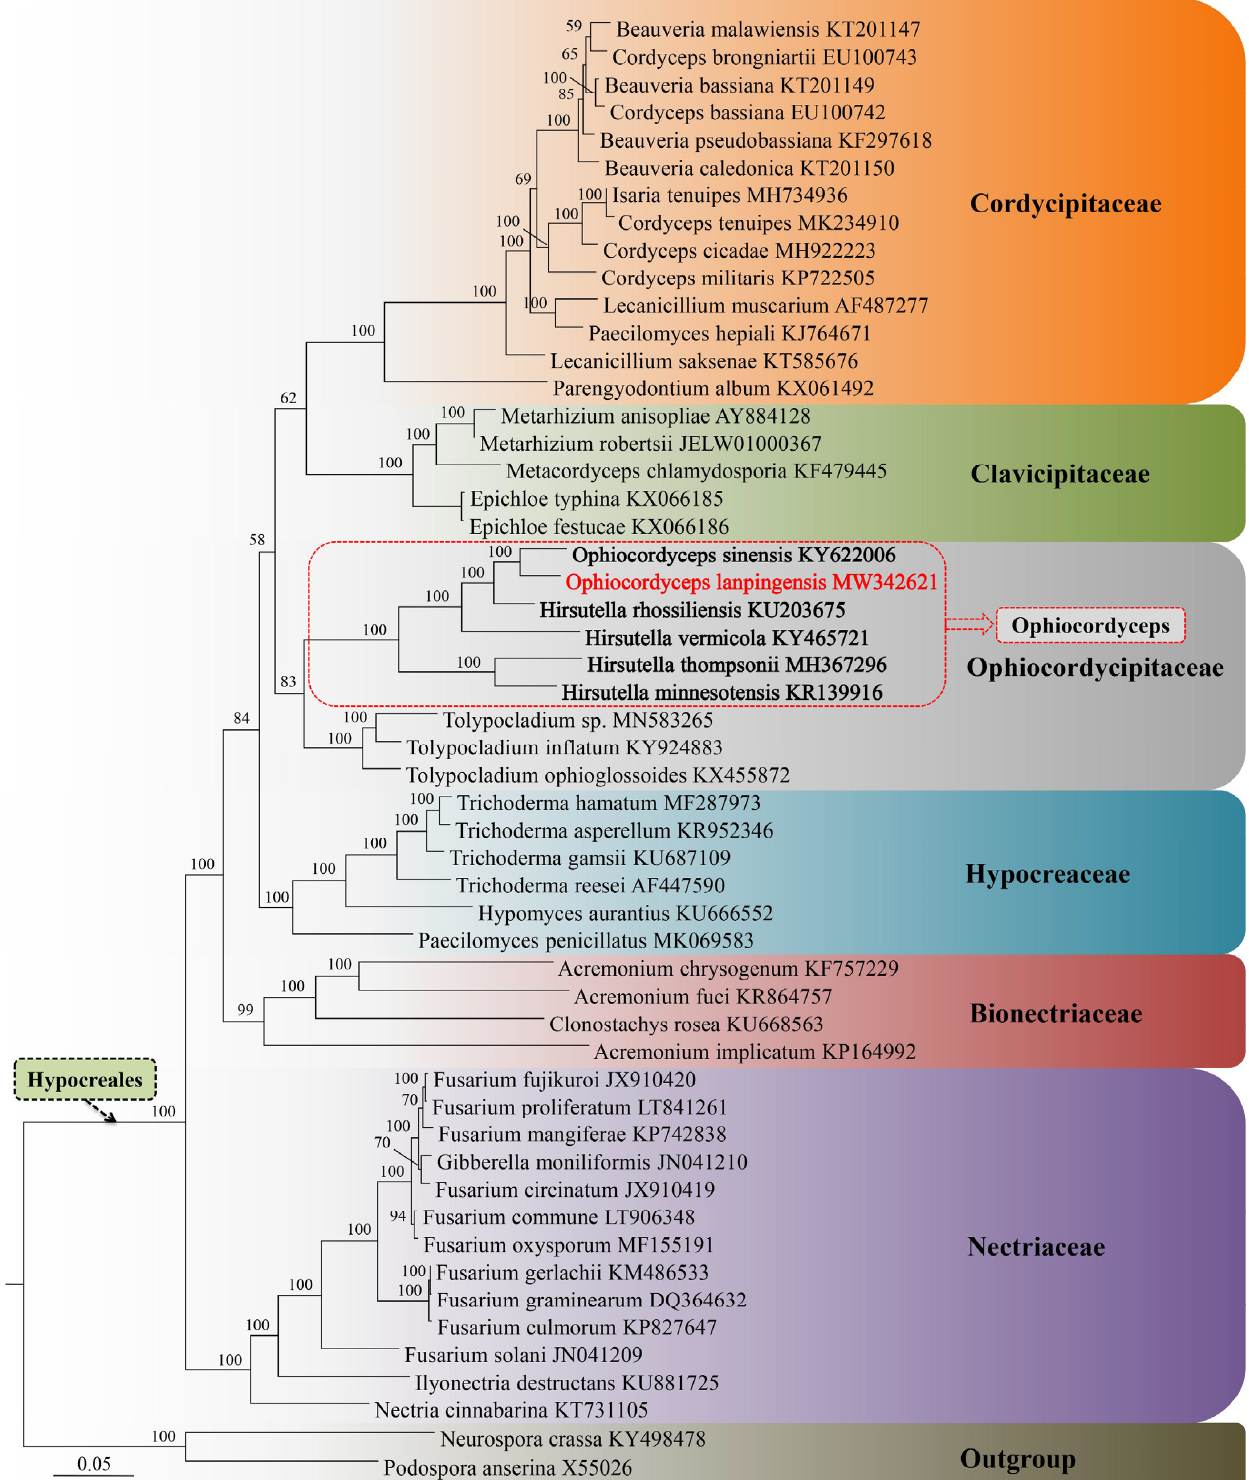
Figure 9. Phylogenetic placement of O. lanpingensis in the order Hypocreales, inferred from mi- togenomes based on Bayesian